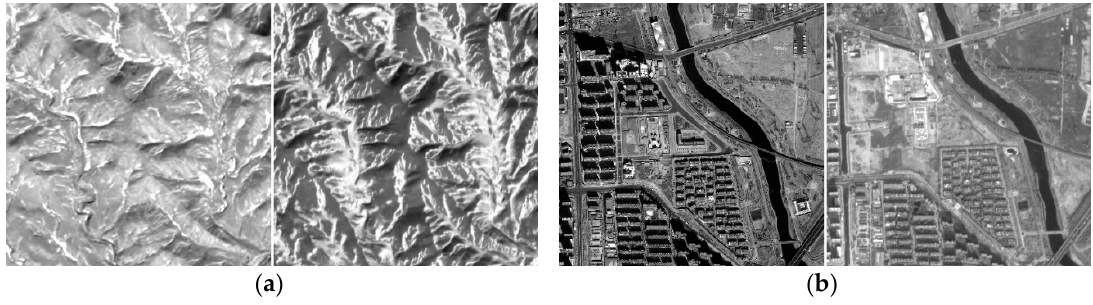
Figure 1. Non-linear intensity differences and textural changes between image pairs: ( a ) The image pair consists of GF-1 and ZY-3 sensor images and ( b ) GF-2 and ZY-3 sensor images.